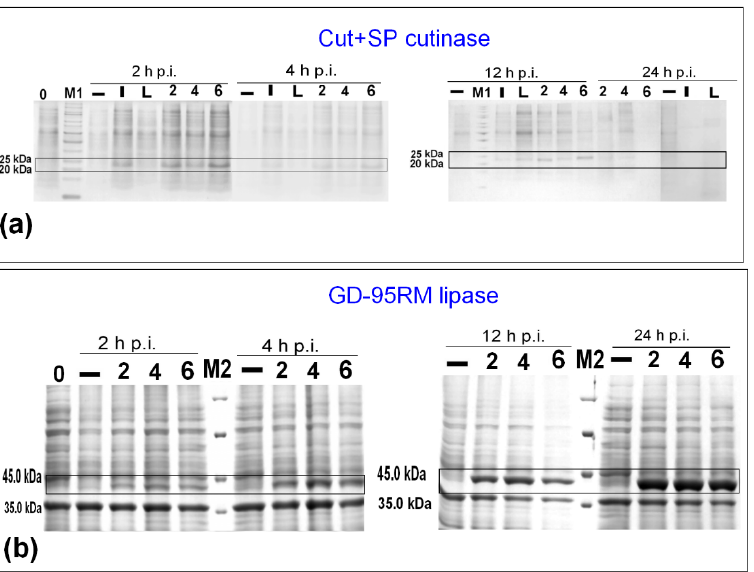
Figure 2. The expression induction of recombinant Cut+SP cutinase ( a ) and GD-95RM lipase ( b ) using MP as an inducer. M1—PageRuler™ Unstained Protein Ladder; M2—Pierce™ Unstained Protein MW Marker; 2/4/6—concentration of MP as an inducer (mM); 0—time point when E. coli BL21 (DE3) was subjected for induction; —–control sample of recombinant E. coli BL21 (DE3) cells growing without induction; I—for induction IPTG (1 mM) was used as an inducer; L—for induction lactose (4 mM) was used as an inducer; p.i.—post-induction time in hours. The target enzymes are marked with black boxes. Tricine-SDS-PAGE was used for Cut+SP analysis and glycine-SDS-PAGE for